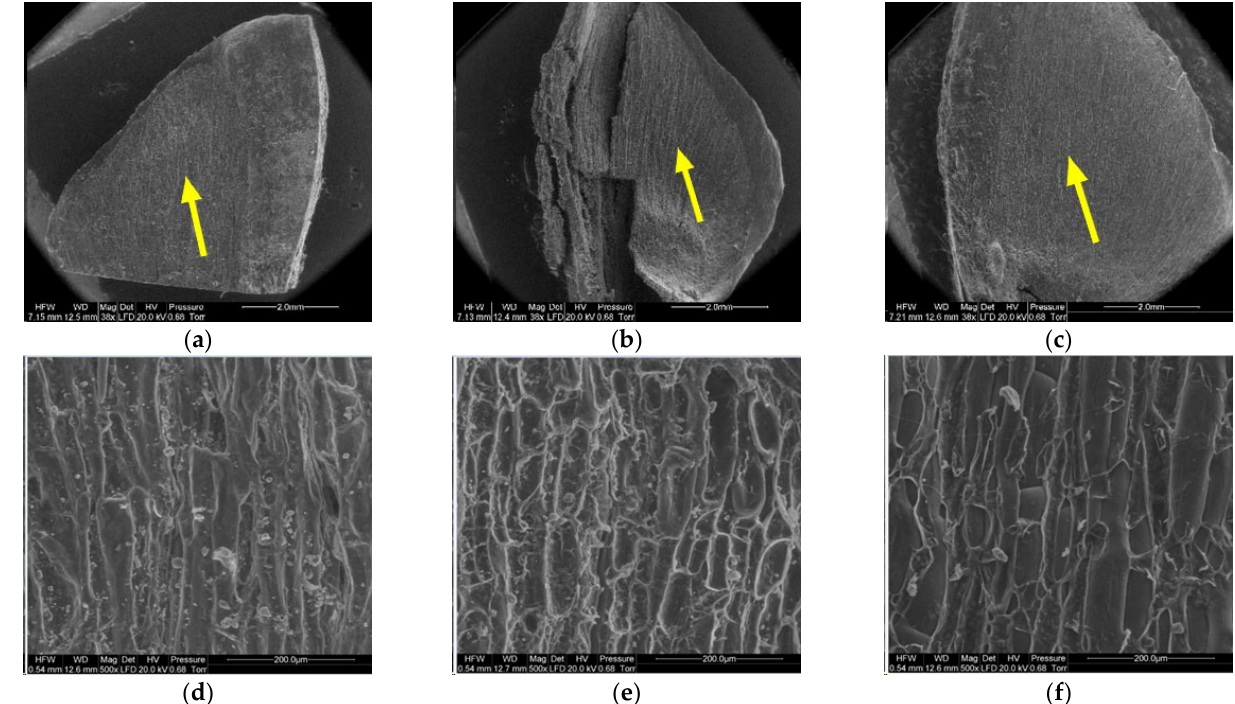
Figure 9. Inner side of larch scale. Wing area: ( a ) MC = 20%, zoom 50×; ( b ) MC = 10%, zoom 50×; ( c ) MC = 5%, zoom 50×; ( d ) MC = 20%, zoom 500×; ( e ) MC = 10%, zoom 500×; and ( f ) MC = 5%, zoom 500×.